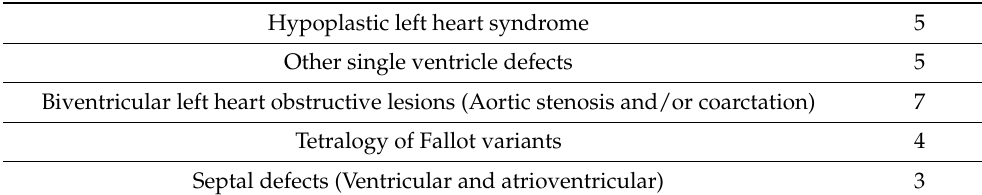
Table 2. Types of congenital heart defects in the study population ( N =